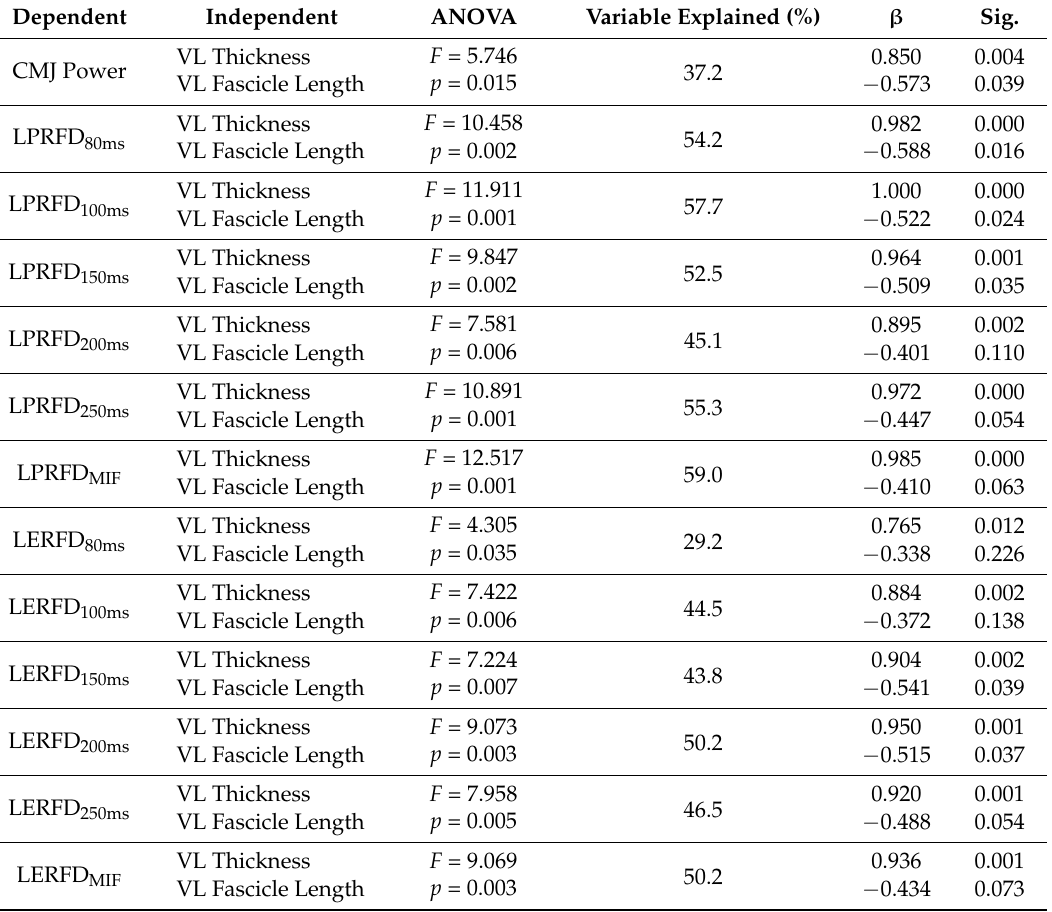
Table 3. Results from multiple linear regression analysis for both groups of taekwondo and thrower athletes ( N =